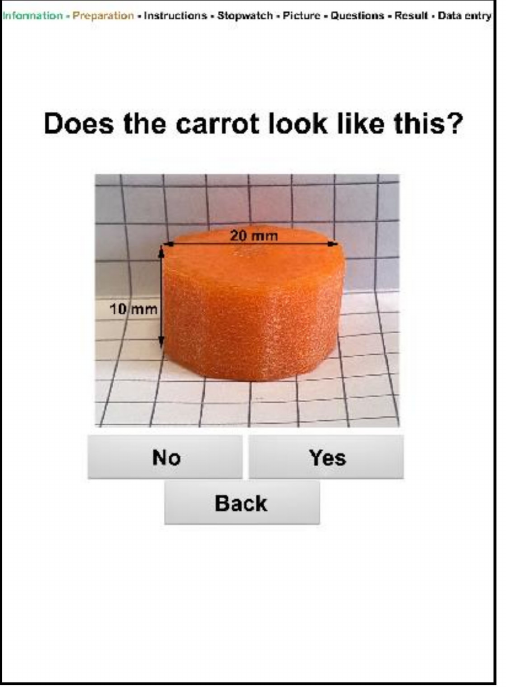
Figure 2. Screenshot of the digital MDA control question regarding the correct size of the carrot cube (20 × 20 × 10 mm) for standardized investigation.